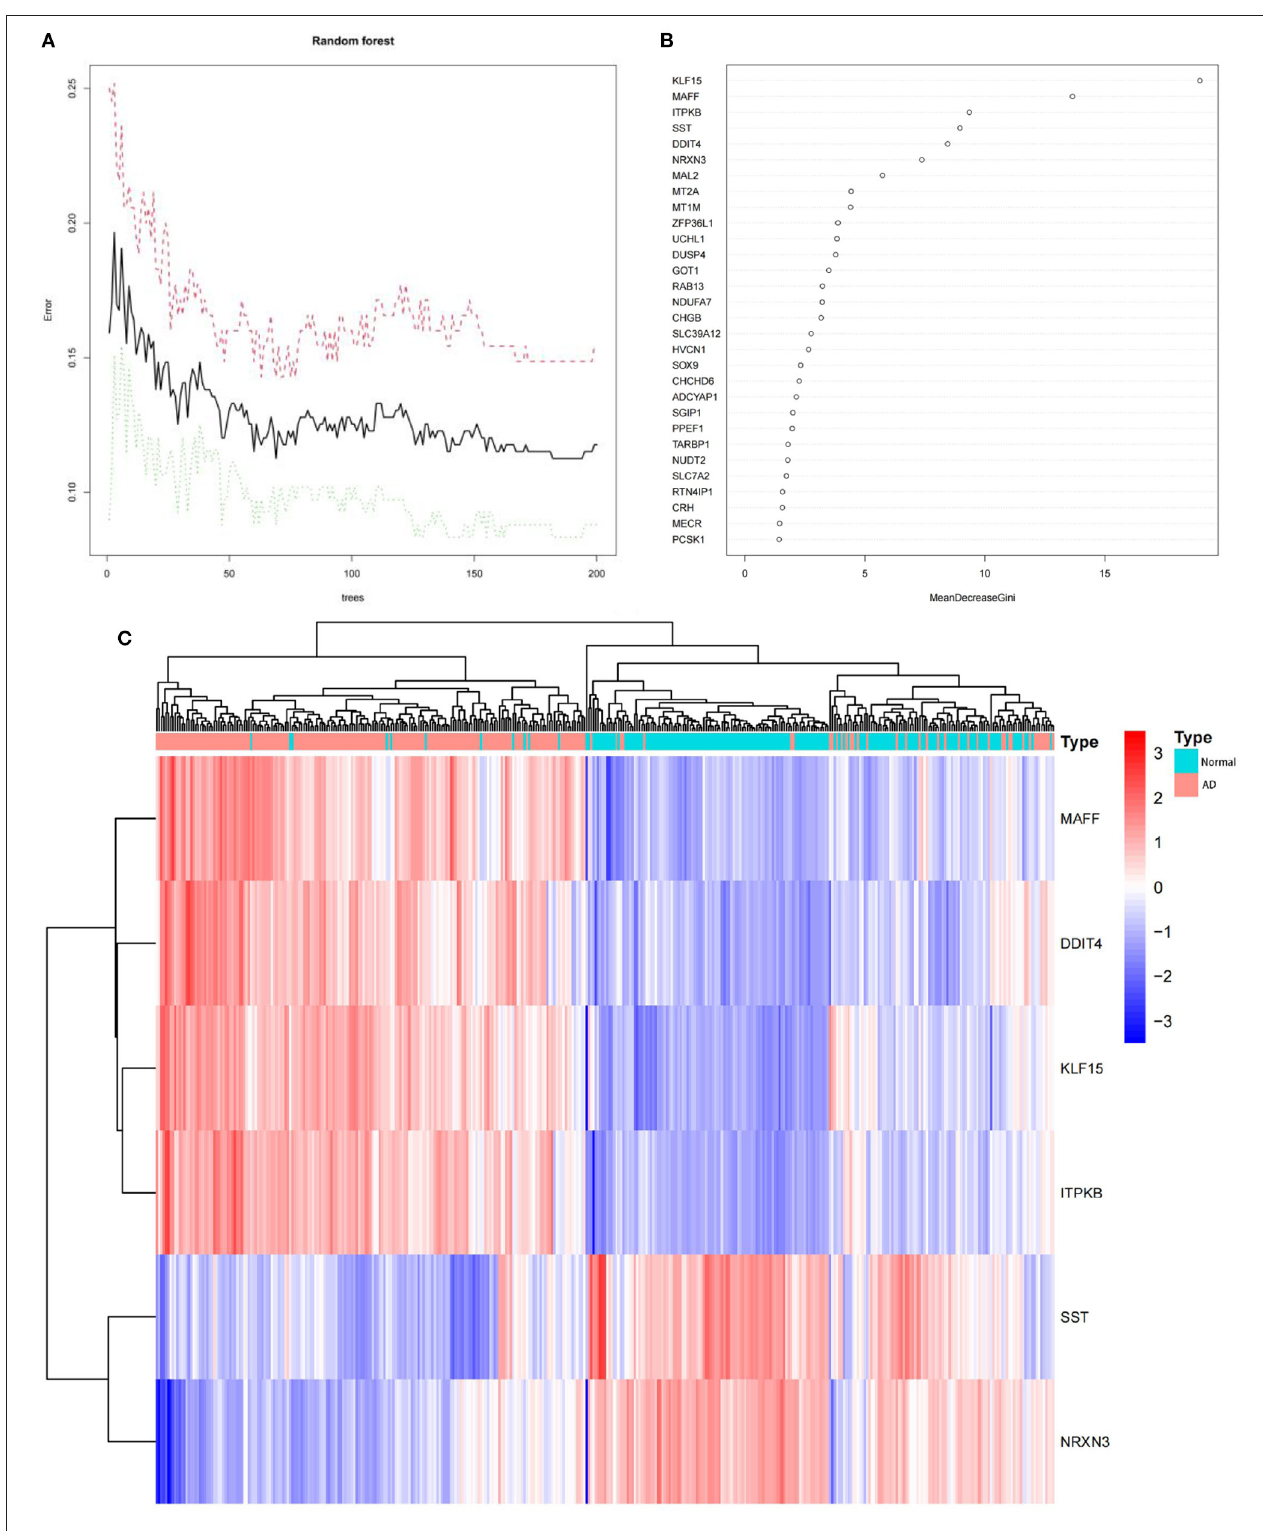
FIGURE 4 | (A) The correlation plot between the number of RF trees and model error. The error rate is stable when the number of RF trees is around 190. (B) The Gini coefficient method in a random forest classifier yielded the following results. The importance index is on the x-axis, and the genetic variable is on the y-axis. (C) The heatmap of six key genes generated by random forest. The red band indicate AD, while the blue band indicate normal. Red blocks indicate high-expressed genes, and blue blocks low-expressed genes.